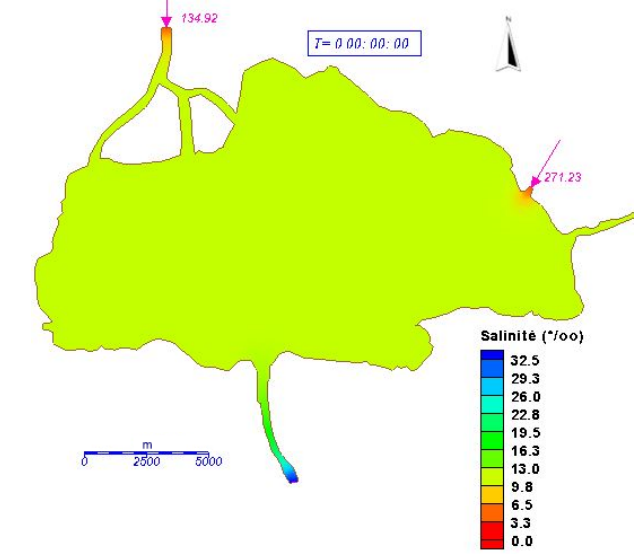
Figure 7. Spatio-temporal variation in salinity during a flood period after 8h of simulation.